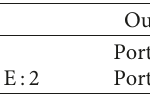
Table 4: Routing rules for Figure 9.